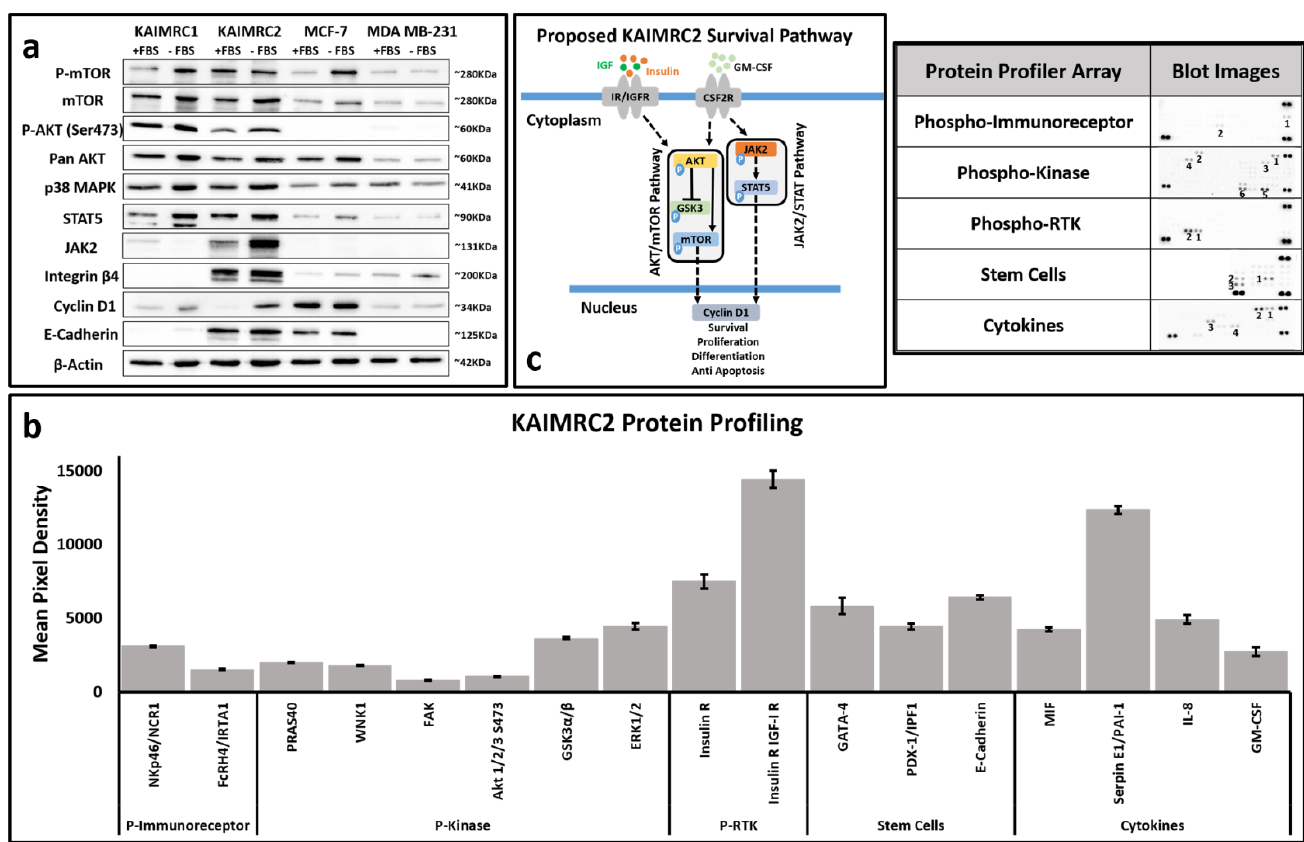
Figure 3. ( a , b ) Protein profiling of KAMRC2 cell line. ( a ) Western blot analysis of comparison of several breast carcinoma cell lines revealed that KAIMRC2 has constitutively active AKT and mTOR . Strongly positive Integrin β 4 and E-cadherin are indicative of cancer stemlike subtype. ( b ) Several protein profiler arrays showed noticeable insulin receptor expression, GATA-4 , PDX-1 , E-cadherin , and Serpin E1 . Interestingly, high expression of Cyclin D1 was found in the starvation condition in KAIMRC2 cells. ( c ) Our proposed model of the KAIMRC2 cell line survival